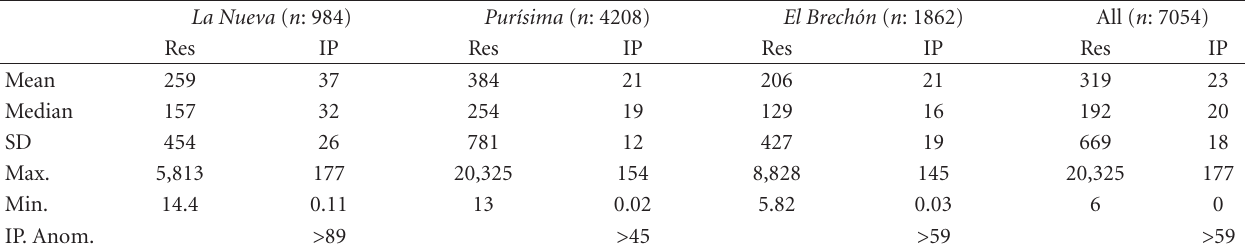
Table 2: Resistivity (ohm · m) and chargeability values (mV/V). Chargeability anomalies are identified as the mean + 2